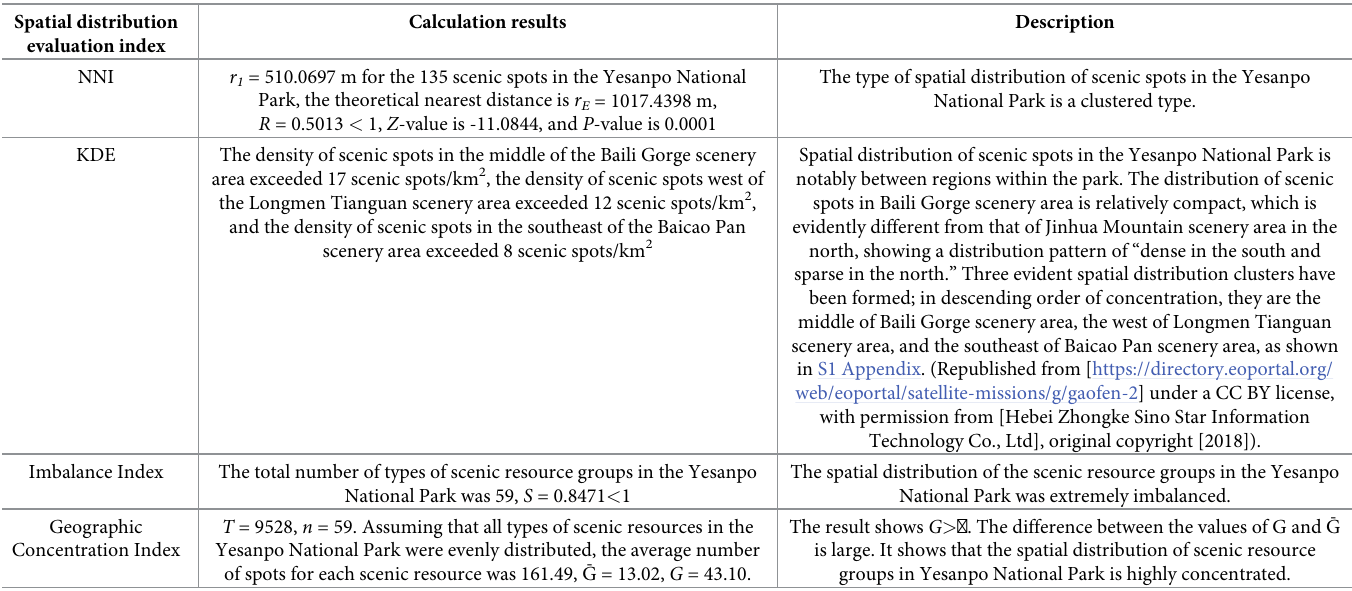
Table 7. Spatial distribution evaluation results.